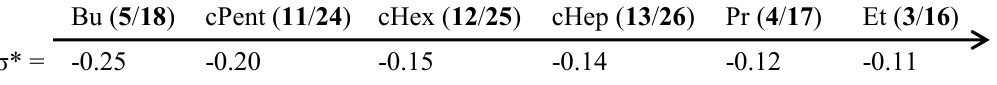
Figure 2. Increase of the general antimicrobial activity owing to the R 2 substituent in dependence on the electronic properties are expressed as electronic constants σ *.